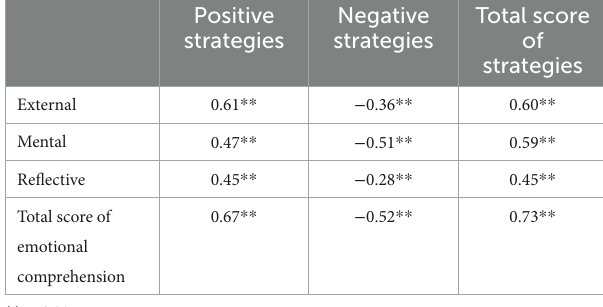
TABLE 6 Correlation analysis results of children’s peer conflict resolution strategies and emotional comprehension.